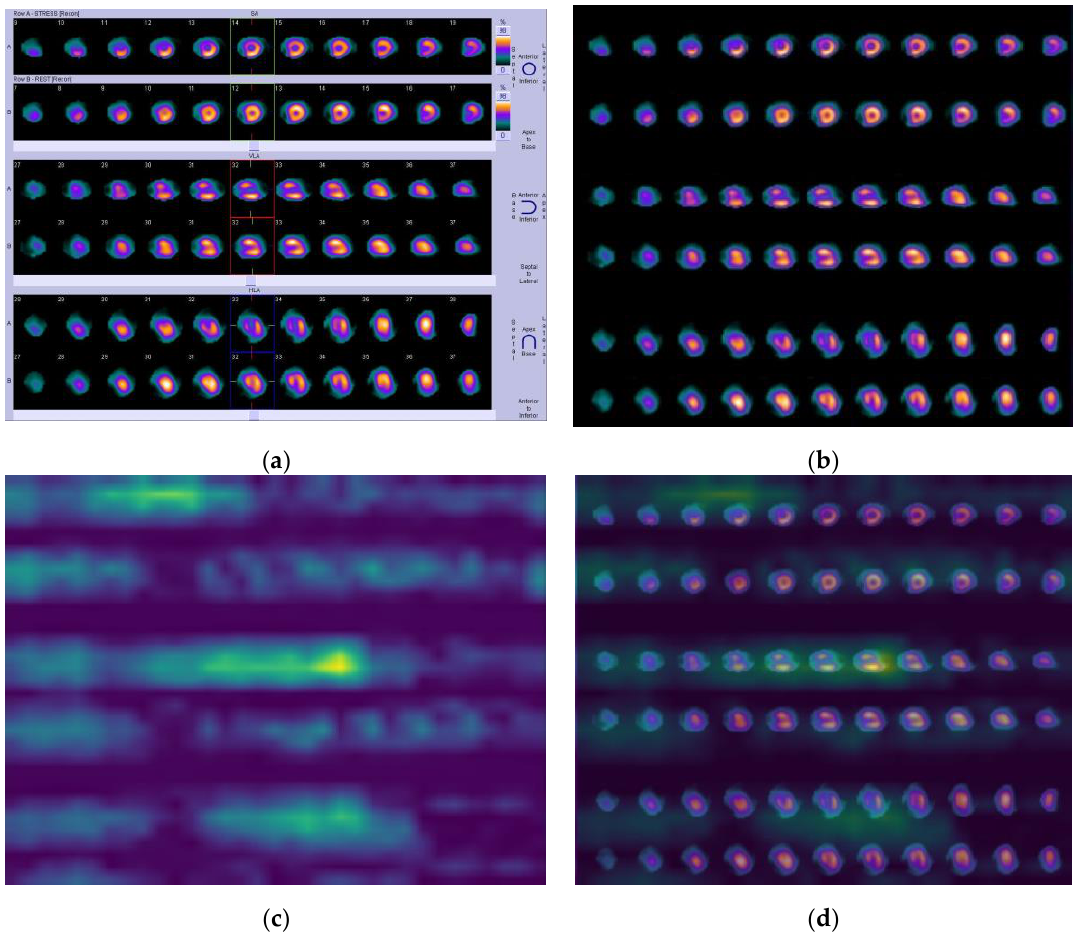
Figure 6. Case A. ( a ) Initial image; ( b ) processed image; ( c ) heatmap; and ( d ) visualized results generated by Grad-CAM for ischemia.